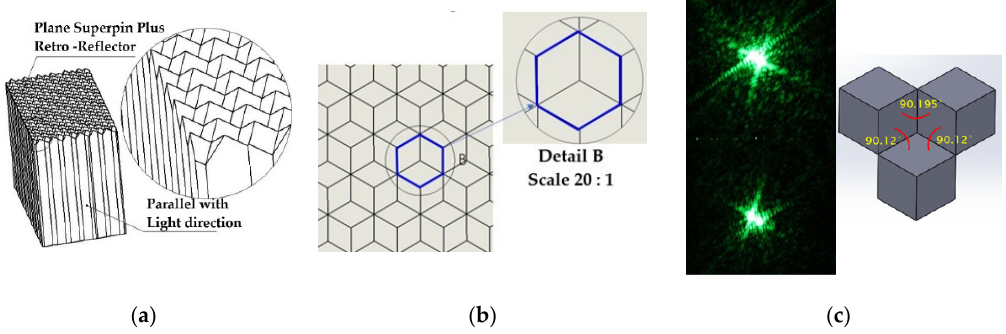
Figure 2. ( a ) A 3D design of flat corner cube SuperPin Plus retro-reflector; ( b ) a group of pins and its reflecting surfaces (blue line inner region); and ( c ) SuperPin retroreflected light pattern [24].